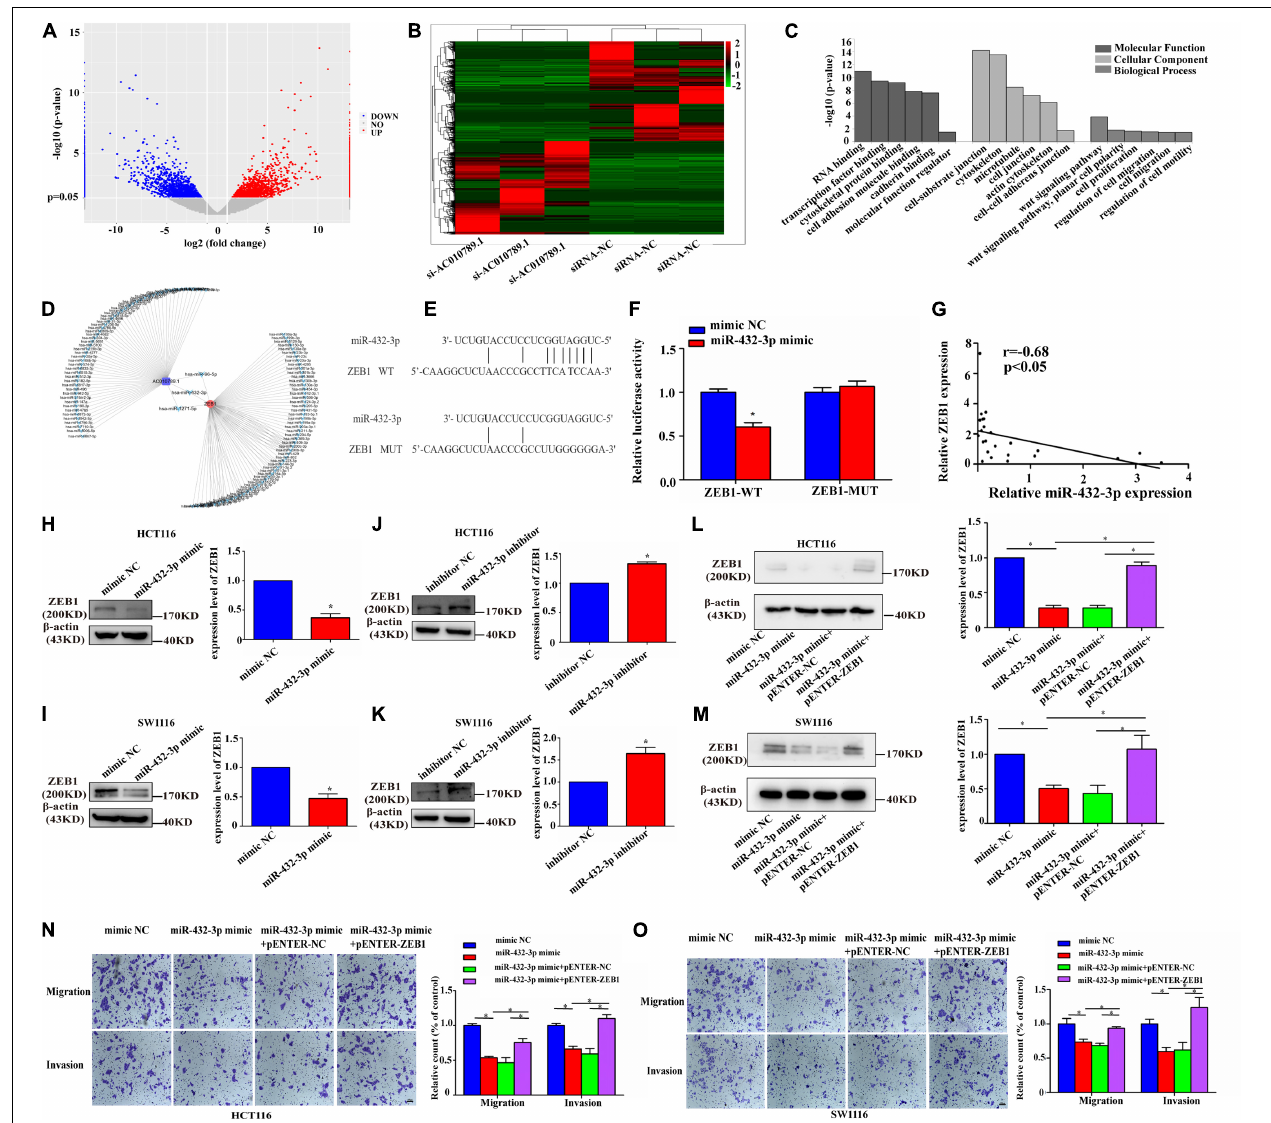
FIGURE 5 | ZEB1 is a direct target of miR-432-3p in CRC migration and invasion. (A,B) RNA sequencing analysis of mRNAs from siRNA-NC and si-AC010789.1 cells were presented in a volcano plot and heatmap. (C) The Gene Ontology (GO) analysis and significantly enriched GO terms of changed targeted mRNAs in siRNA-NC and si-AC010789.1 cells on their molecular function, cellular component, and biological process. The statistically significant results were defined with –log10 ( P -value) > 1.40 as the cut-off criterion. (D) Schematic representation of the predicted binding miRNA for AC010789.1 and ZEB1. (E) The schematic model showed the putative binding sites of miR-432-3p on ZEB1. (F) ZEB1-WT and ZEB1-MUT reporter plasmid in HCT116 cells co-transfected with mimic NC or miR-432-3p mimic. (G) Correlation analysis of ZEB1 expression and miR-432-3p expression levels in 24 CRC tissues. (H,I) The protein level of ZEB1 in HCT116 and SW1116 cells transfected with mimic NC or miR-432-3p mimic. (J,K) The protein level of ZEB1 in HCT116 and SW1116 cells transfected with inhibitor NC or miR-432-3p inhibitor. (L,M) The protein level of ZEB1 in miR-432-3p overexpressed-HCT116 cells with or without ZEB1 upregulation. (N,O) Transwell assay for investigating migration and invasion change after transfection with mimic NC, miR-432-3p mimic, miR-432-3p mimic + pENTER-NC, miR-432-3p mimic + pENTER-ZEB1 in HCT116 and SW1116 cells, Scale bar: 100 µ m. Data are representative of three independent experiments and are presented as mean ± SEM. P -values were determined by two-tailed student’s t -test or one-way ANOVA (* P <